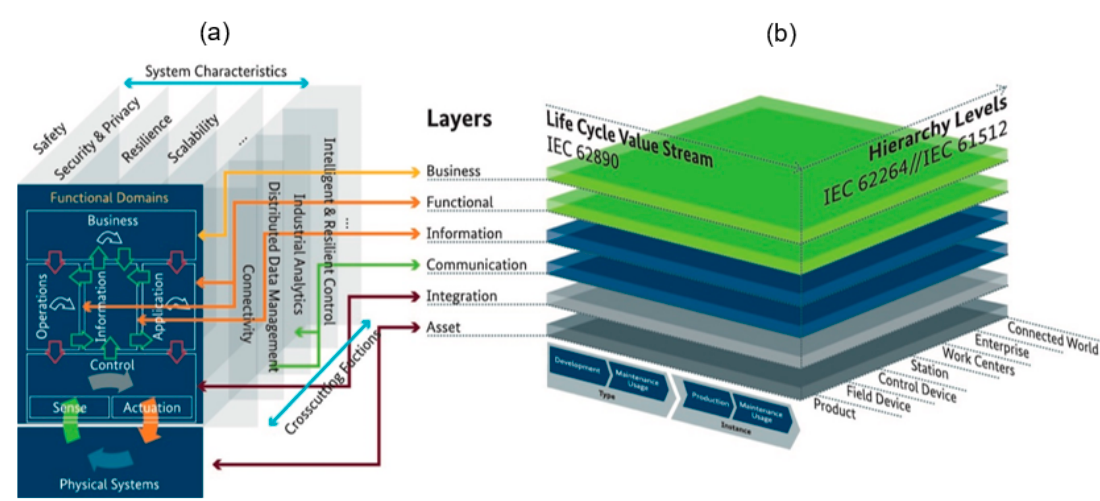
Figure 3. ( a ) The Functional Viewpoint of IIRA. ( b ) RAMI 4.0 ©Plattform Industrie 4.0 and Zentralverband Elektrotechnik-und Elektronikindustrie e.V. (ZVEI) (Reprint with permission).